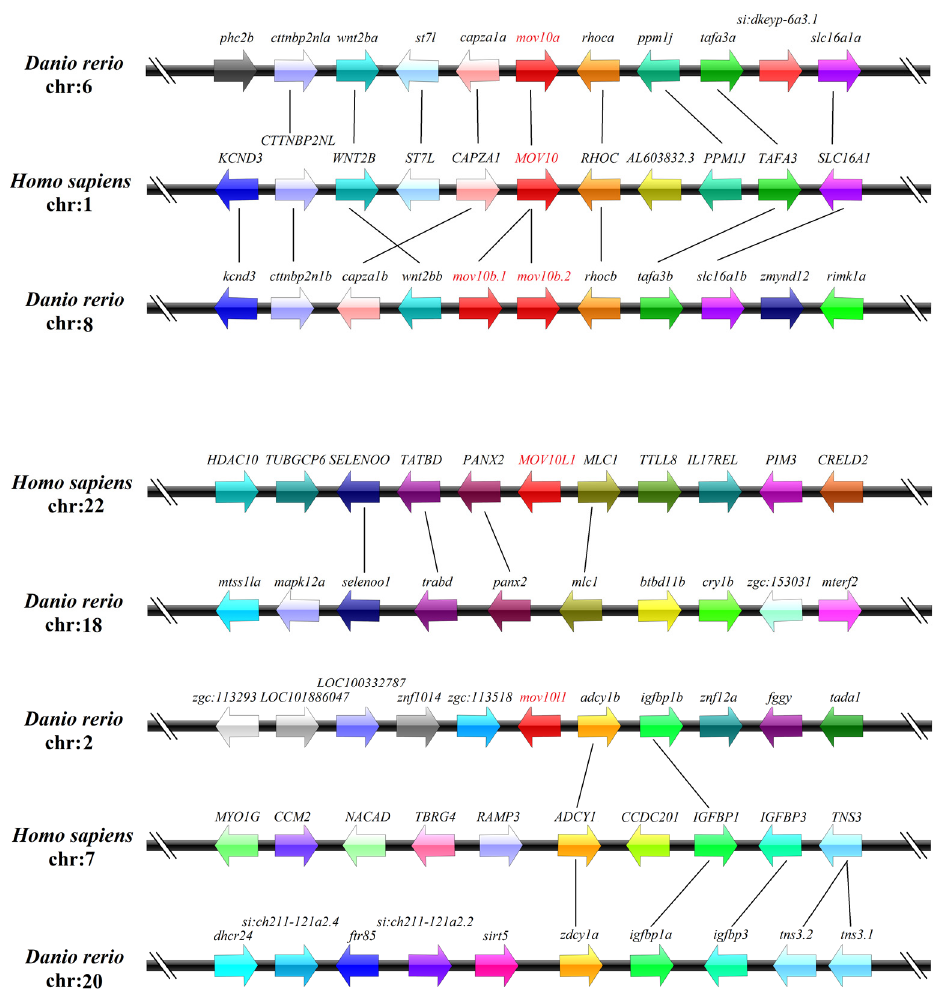
Figure 4. Synteny analyses of the MOV10 and MOV10L1 genes in human and zebrafish. The MOV10 and MOV10L1 genes are marked in red. The same color and the line between the genes of the two species mean they are homologous genes. The direction of the arrow represents the direction of the gene. The spatial distribution between different genes on the chromosome is indicated by bold black lines.